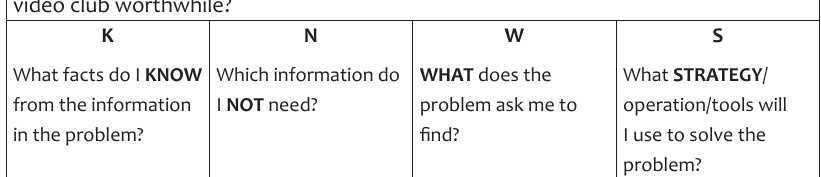
Table 6: K-N-W-S strategy Video Pit rents movies for R3 each per night. They also offer a video club plan. The plan costs R100 per year and allows unlimited rentals at R1 per movie per night plus two free rentals per month. How many movies must you rent in a year to make the video club